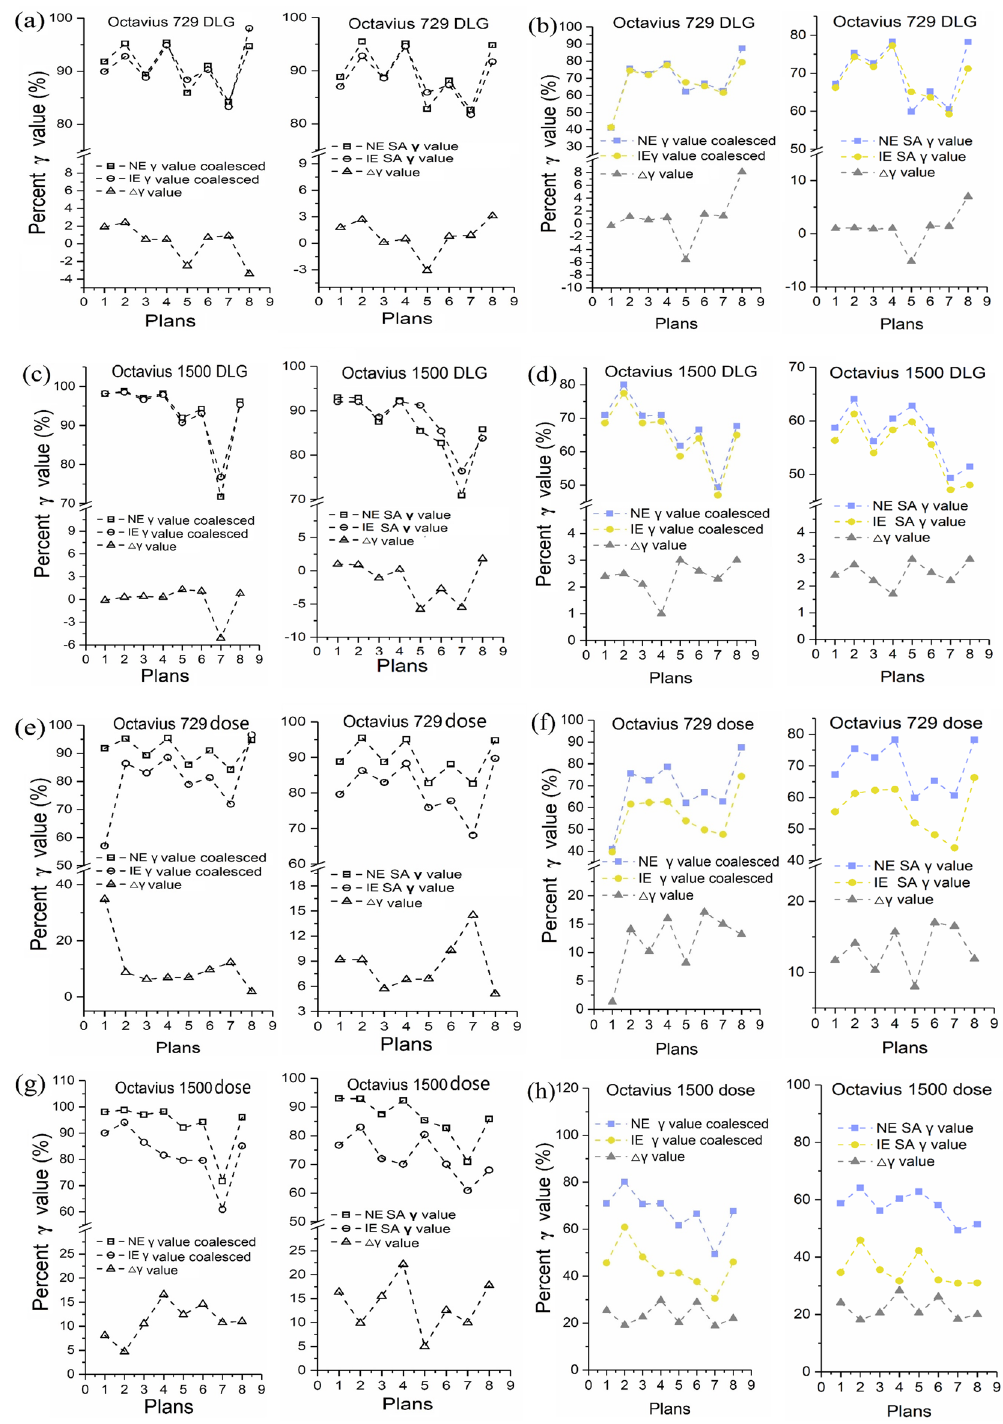
Figure 5. Sensitivity comparisons in detecting DLG and dose errors in various resolution scenarios. (a–h) DLG and dose errors detected by both detectors in coalescence and SA cohorts with global ( a,c,e,g ) and local ( b,d,f,h ) normalization. Comparative ROC curves: (i–j) DLG and dose errors detected by both detectors using mixed γ values in coalescence and SA cohorts; (k–l) DLG and dose errors detected by coalescence and SA procedures using γ values in both detectors; ( m,n ) DLG errors detected by both detectors and coalescence as well as SA cohorts using 1%/1 mm criteria (global normalization). Curves along the diagonal with an AUC of 0.5 indicate a test whose outcome is not significantly different from a random